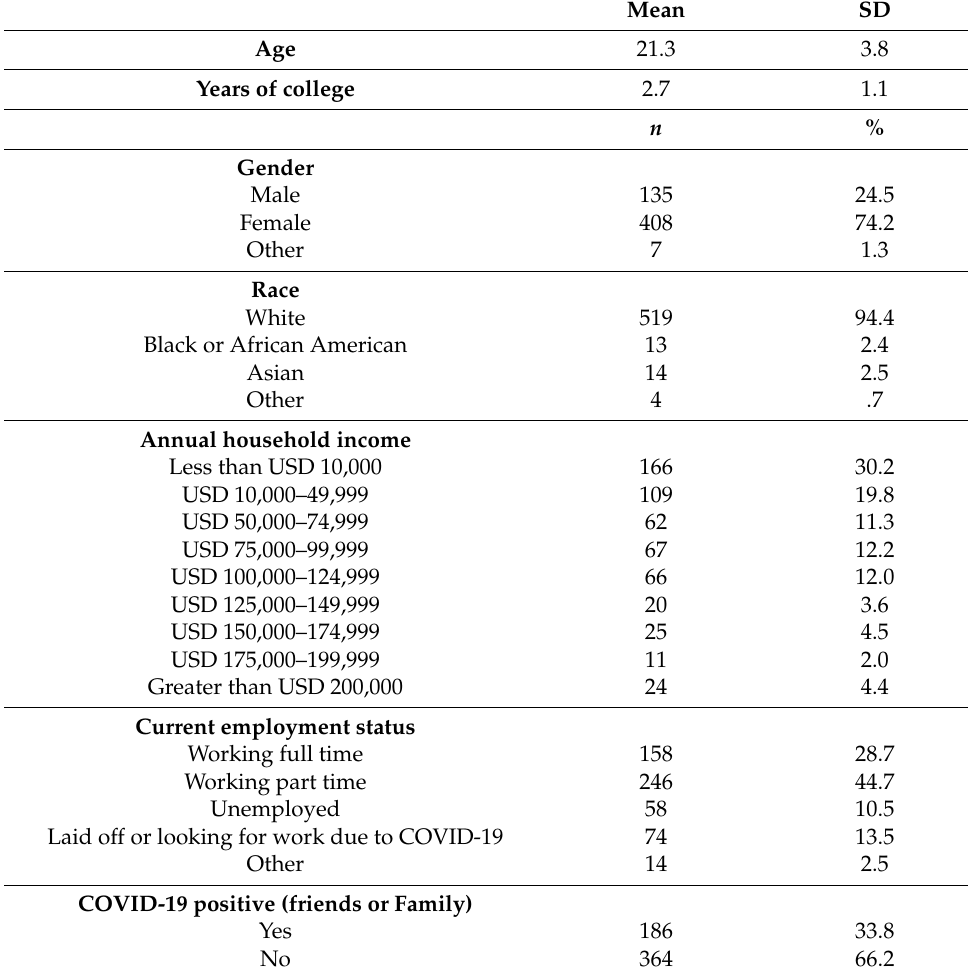
Table 1. Demographic characteristics ( n =